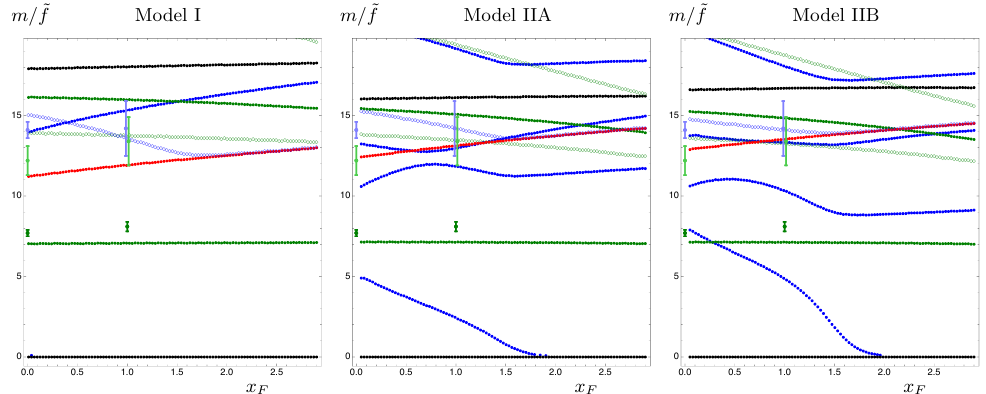
Figure 18 . Spectrum as a function of x F for Models I (left), IIA (center) and IIB (right) compared to lattice results taken from eq. (6.1) (quenched, at x with the vector in green, axial-vector in light green, and the scalar S in light blue. In Model I: ∆ = 3 , g = 8 , ρ = − 7 , ρ = 8 . In Models IIA and IIB: ∆ = 3 , ∆ 5 1 2 and φ = 2 (Model IIA), φ = 0 . 9 (Model IIB). All masses are normalized to the decay constant A B √ ˜ f ≡ f/ N C . The colour coding for the spectrum (computed in the holographic models) is: singlet scalar (blue), non-singlet scalar (blue diamonds), tensor (red), pseudoscalar (black), vector (green), axial-vector (green